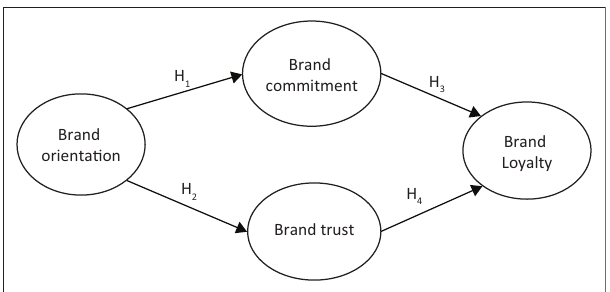
FIGURE 1: Conceptual research